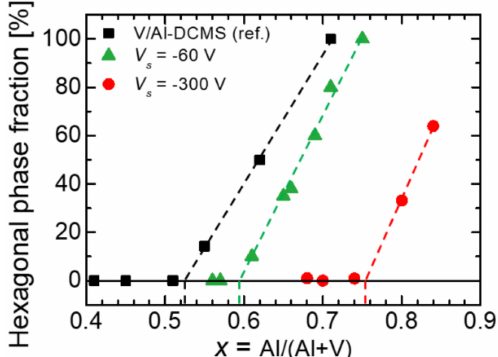
Figure 5. Relative w-AlN content extracted from the areas of wurtzite 1010 and rock salt structure 002 diffraction peaks integrated over all ψ angles and normalized to random powder XRD patterns plotted as a function of Al concentration x for V 1 − x Al x N films grown with ( a ) conventional direct current magnetron sputtering (DCMS) (Al/V-DCMS), ( b ) hybrid Al-HiPIMS/V-DCMS with synchronous substrate bias of − 60 V, and ( c ) hybrid Al-HiPIMS/V-DCMS with synchronous substrate bias of − 300 V. The critical Al solubilities x max are obtained by